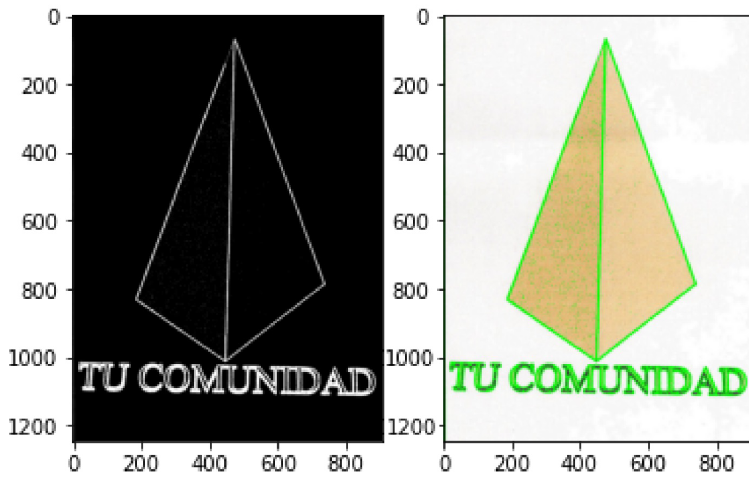
Figure 6. Contour detection in objects.